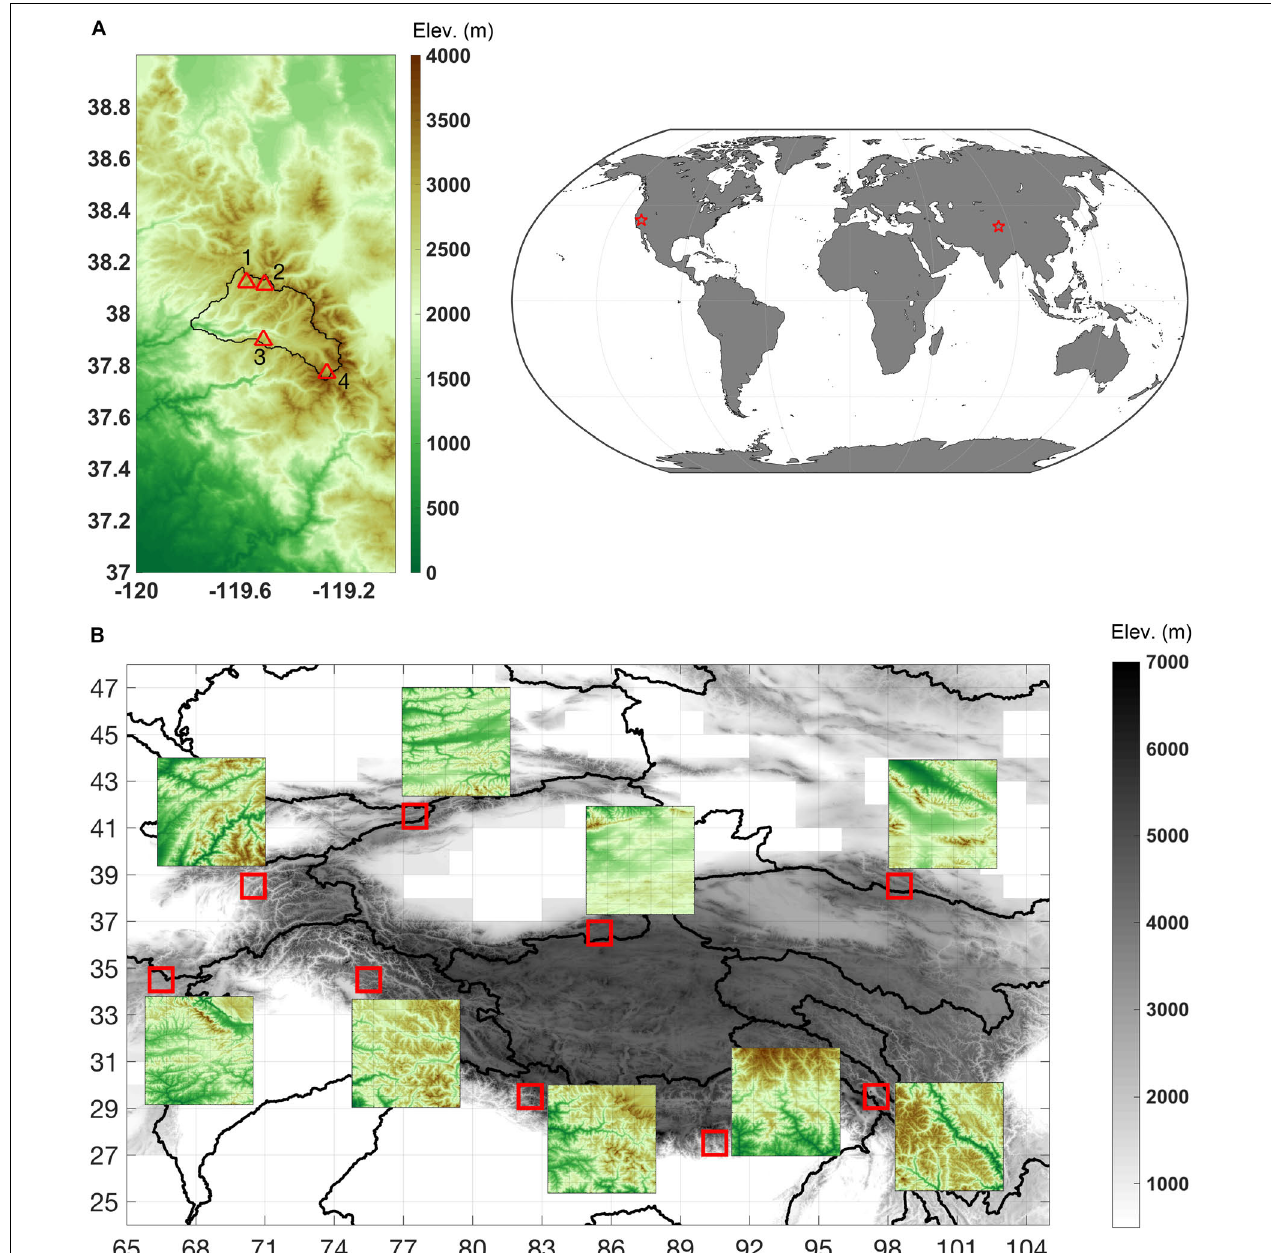
FIGURE 1 | Site maps showing the DEMs (elevations in meters) for (A) the verification site in Tuolumne River watershed in California and (B) the sample tiles across High-Mountain Asia (HMA). The Tuolumne watershed boundary is shown with the black line in panel (A) along with four sample locations used to illustrate verification in Figure 7 . Sample tiles over HMA are outlined in red with the color insets showing the respective DEMs in more detail. Inset DEMs do not use the same colorbar range across all tiles, but instead a localized range for each tile to emphasize the spatial patterns that are seen in subsequent figures. The tiles examined are labeled with their lower left corner and consist of: (34 ◦ N , 66 ◦ E ), (41 ◦ N , 77 ◦ E ), (34 ◦ N , 75 ◦ E ), (38 ◦ N , 70 ◦ E ), (29 ◦ N , 82 ◦ E ), (36 ◦ N , 85 ◦ E ), (27 ◦ N , 90 ◦ E ), (29 ◦ N , 97 ◦ E ), (38 ◦ N , 98 ◦ E